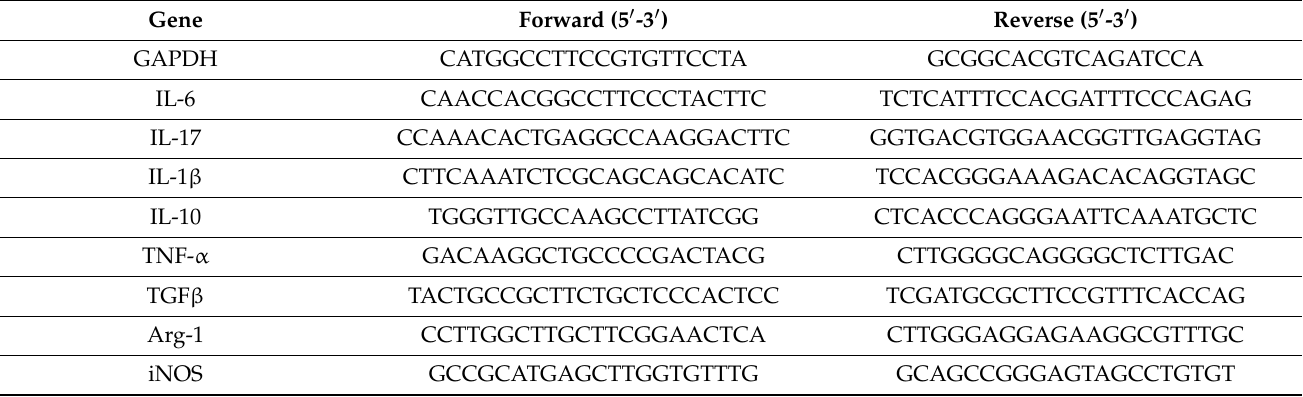
Table 1. Sequences of the primers or primers for genes that code for cytokines and pro- inflammatory